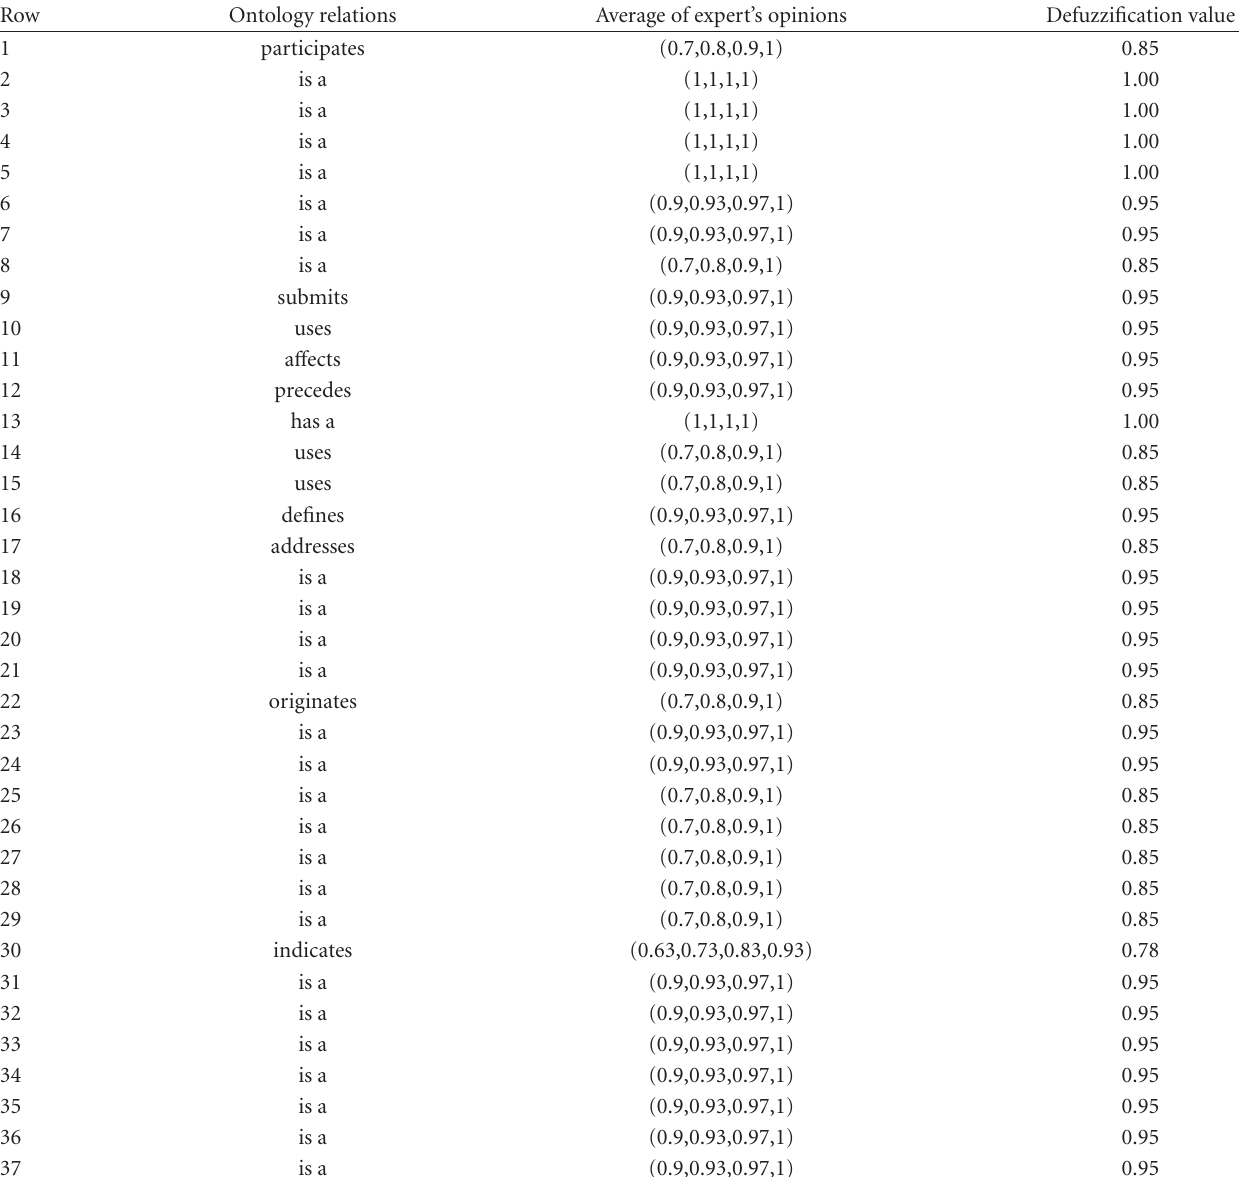
Table 2: Relation’s fuzzification results of the modification process